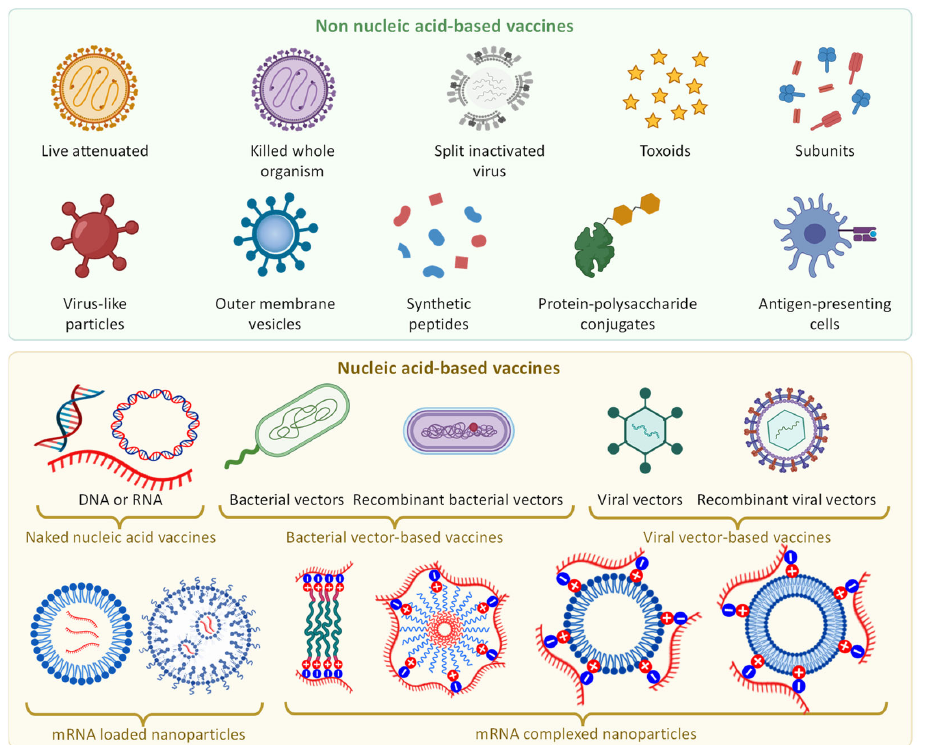
Figure 4. Different types of vaccine.